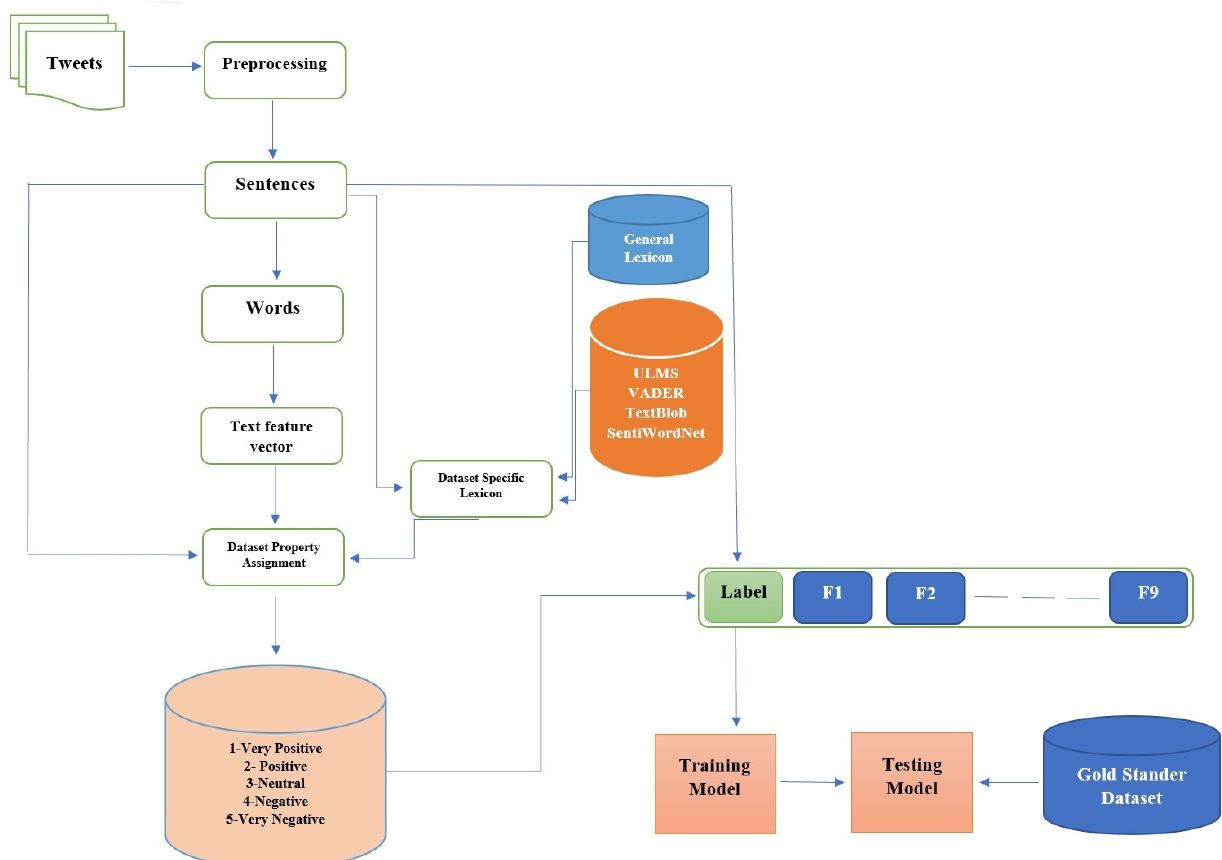
Figure 1. Steps of the suggested